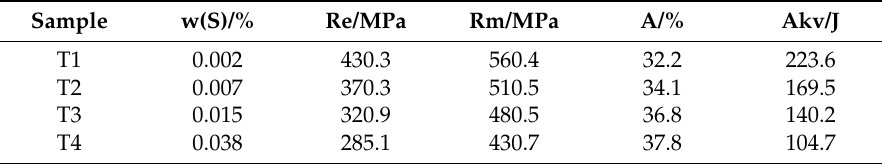
Note: Re: yield strength, Rm: tensile strength, A: elongation, Ak: impact